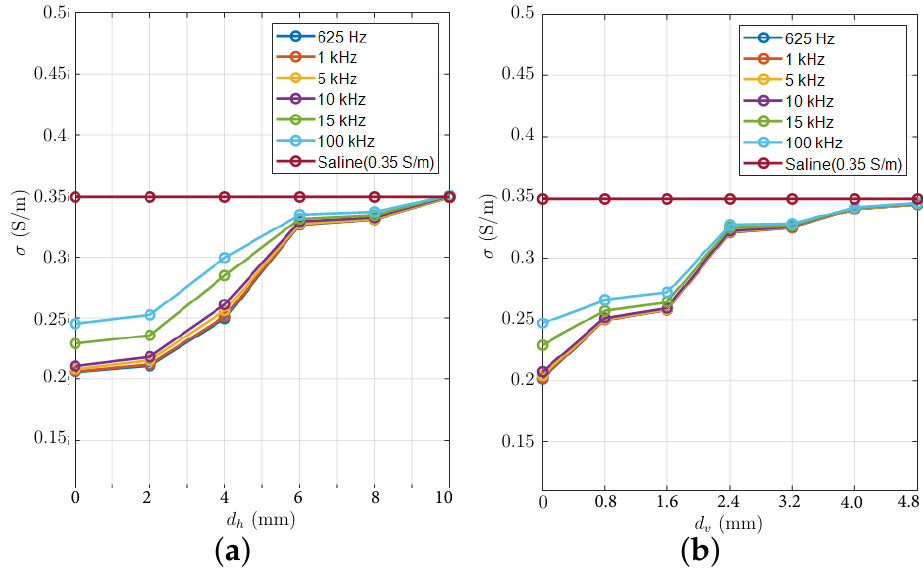
Figure 4. Conductivity spectra of the carrot in saline phantom from 0.625 to 100 kHz when the carrot was moving horizontally ( a ) and vertically ( b ) apart from the center of the probe. ( a ) The conductivity σ with respect to the horizontal distance d h of carrot to the center of the probe. ( b ) The conductivity σ with respect to the vertical distance d v between the top surface of the carrot and the bottom of the